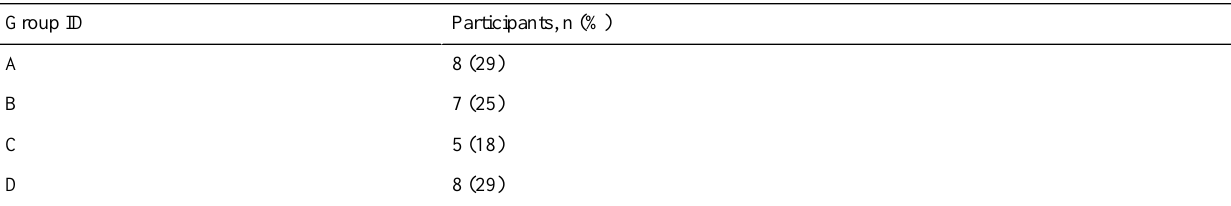
Table 1. Focus group composition